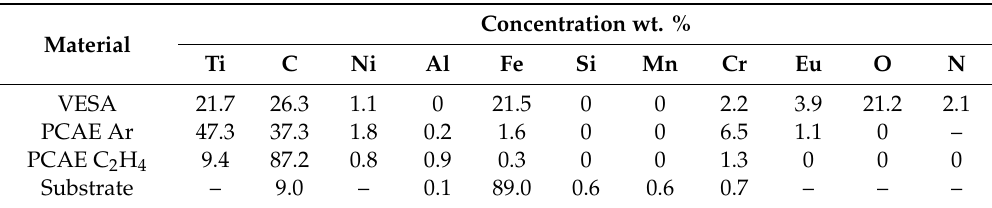
Table 1. Chemical composition of VESA and PCAE coatings. Concentration wt. Material